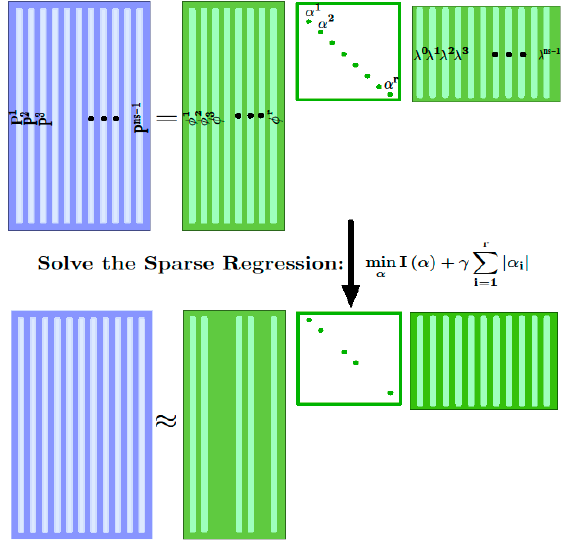
Figure 2. Step of solving for sparsity structure (Bao and Gildin, 2017).